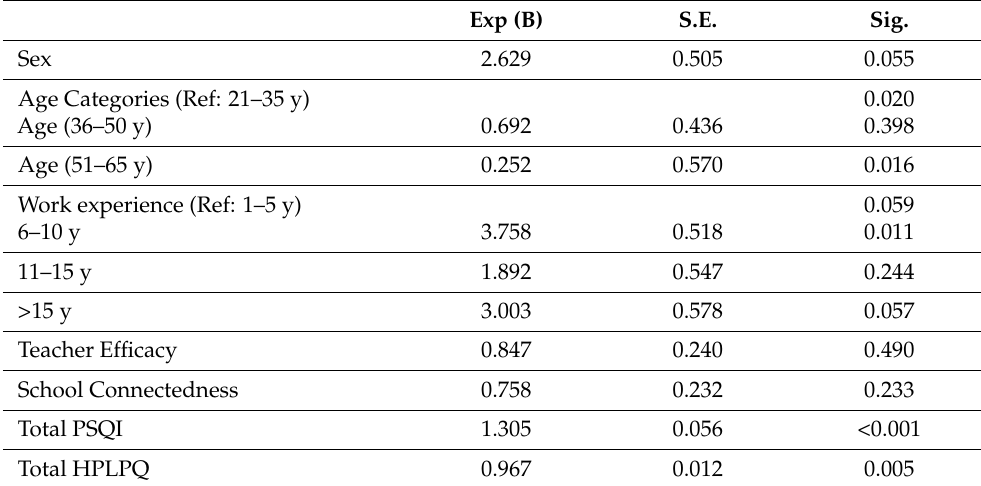
Table 6. Results from multivariate logistic analysis that evaluated various participants’ characteristics as determinants of